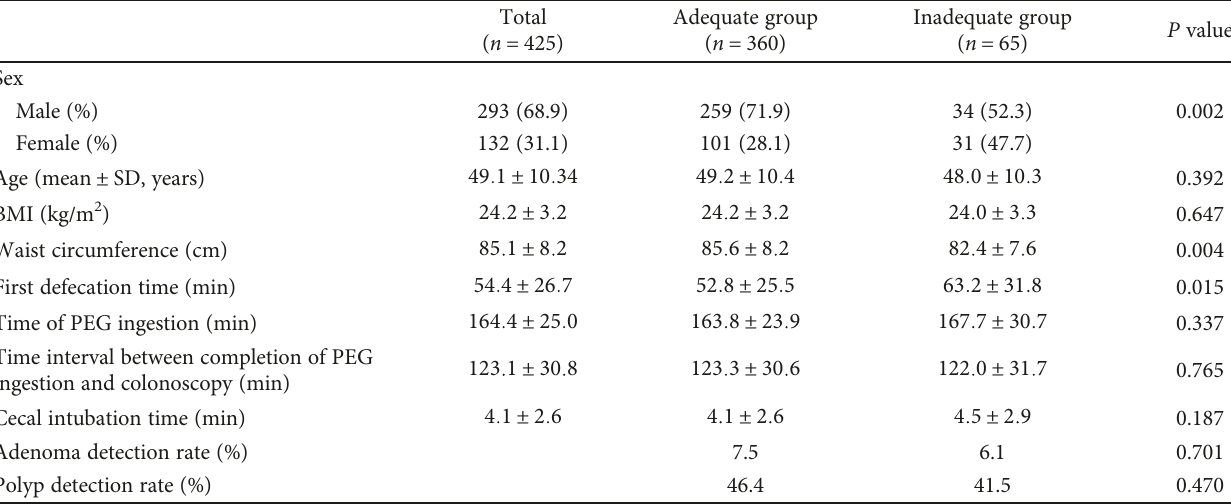
Table 1: Characteristics and univariate analysis of the adequate preparation group and inadequate preparation group in the proximal colon.